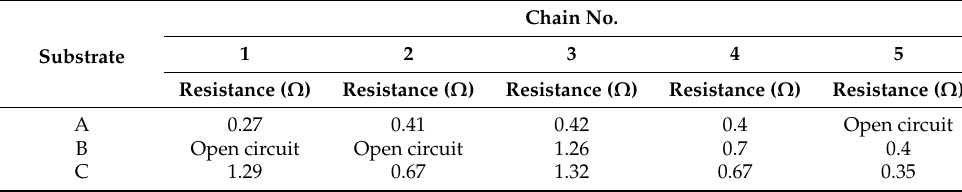
Table 3. Resistance measurements of daisy chains (30 mm × 4